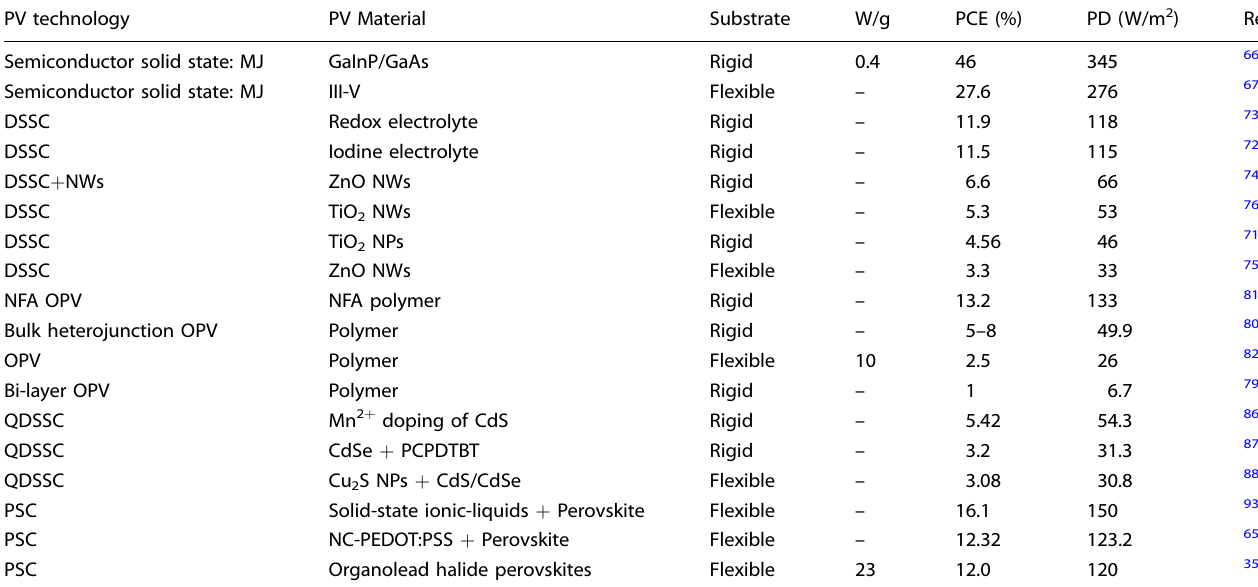
Table 1. PV cell ef fi ciency, including PCE and PD reported in the literature PV